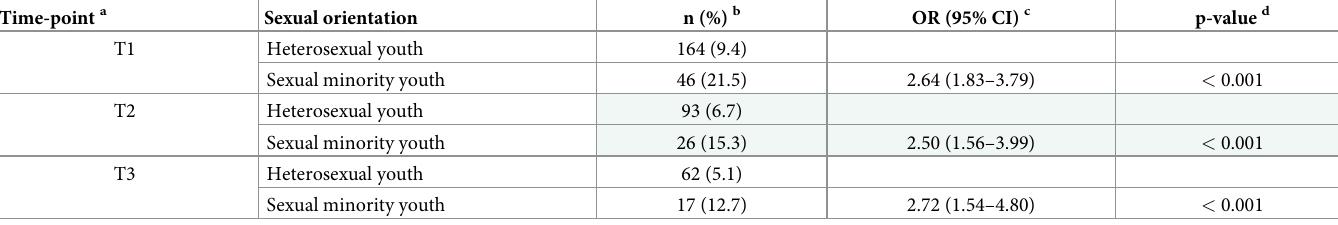
Table 2. Sexual orientation and prevalence of serious suicidal ideation during the study. Time-point